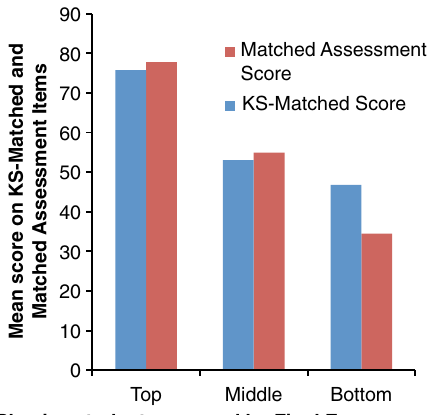
FIG. 3. Average KS-matched scores and actual scores on the matched assessment items broken out by student groupings based on the overall score on the final exam for Physics